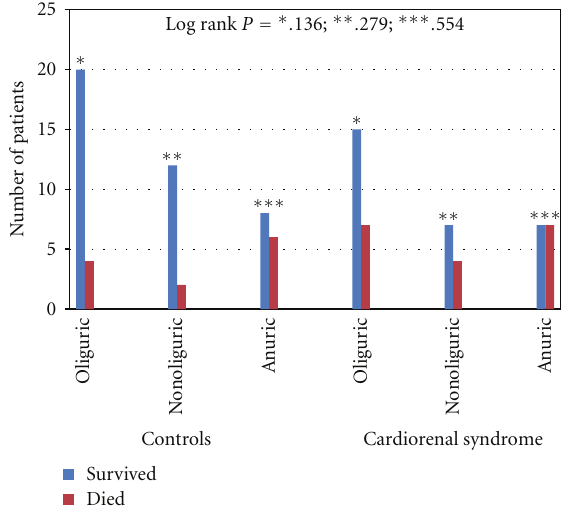
Figure 3: Comparisons between controls and patients with car- diorenal syndrome with regard to survival in the acute kidney injury (AKI) types. The number of patients surviving in oliguric, nonoliguric, and anuric AKI was similar in both groups of patients.